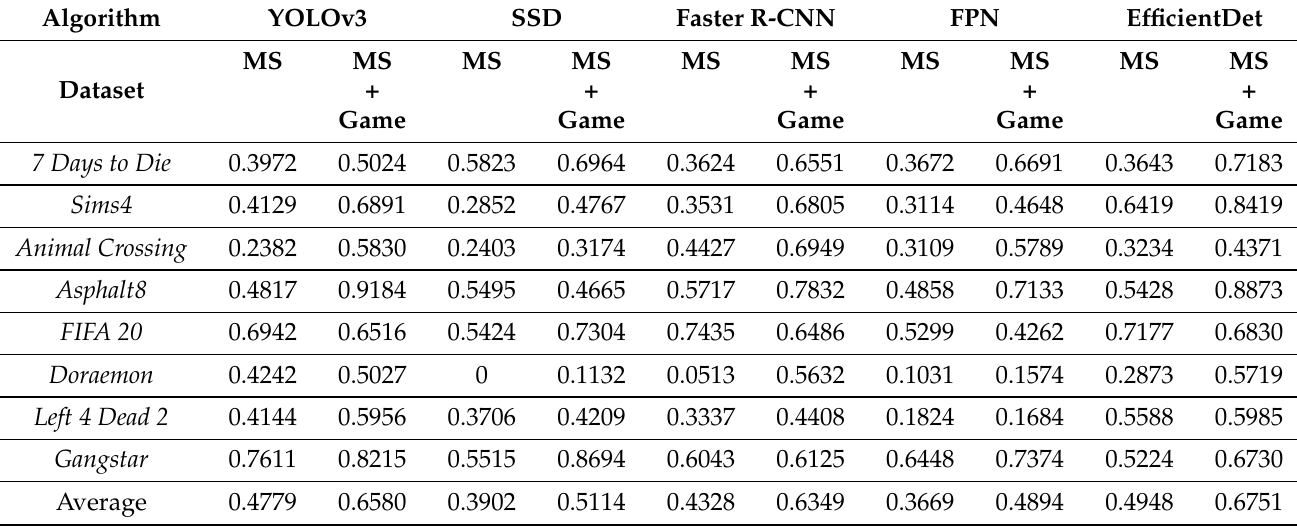
Table 5. The comparison of IoUs for each game. We compared five object detection algorithms pre-trained by MS COCO and retrained by MS COCO with game scenes. Note that MS COCO is abbreviated as MS in the table.